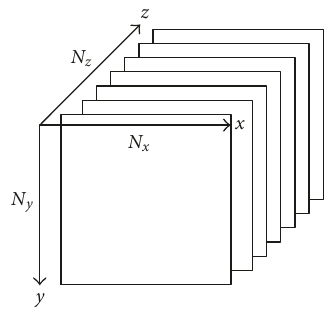
Figure 1: Illustration of cube data